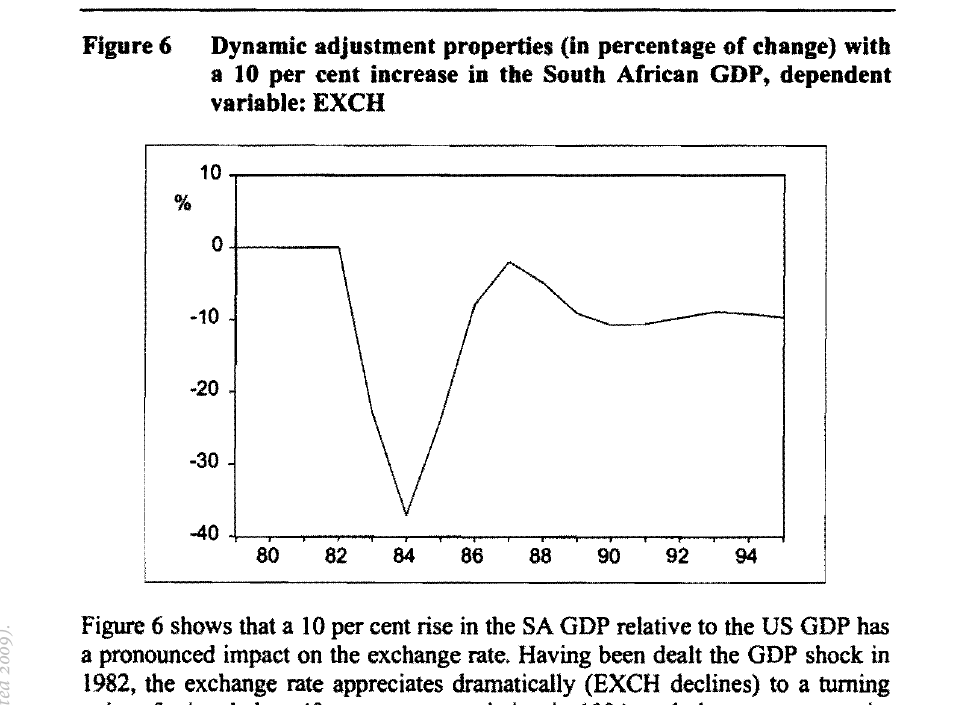
a 10 per cent increase in the South African GDP, dependent variable: